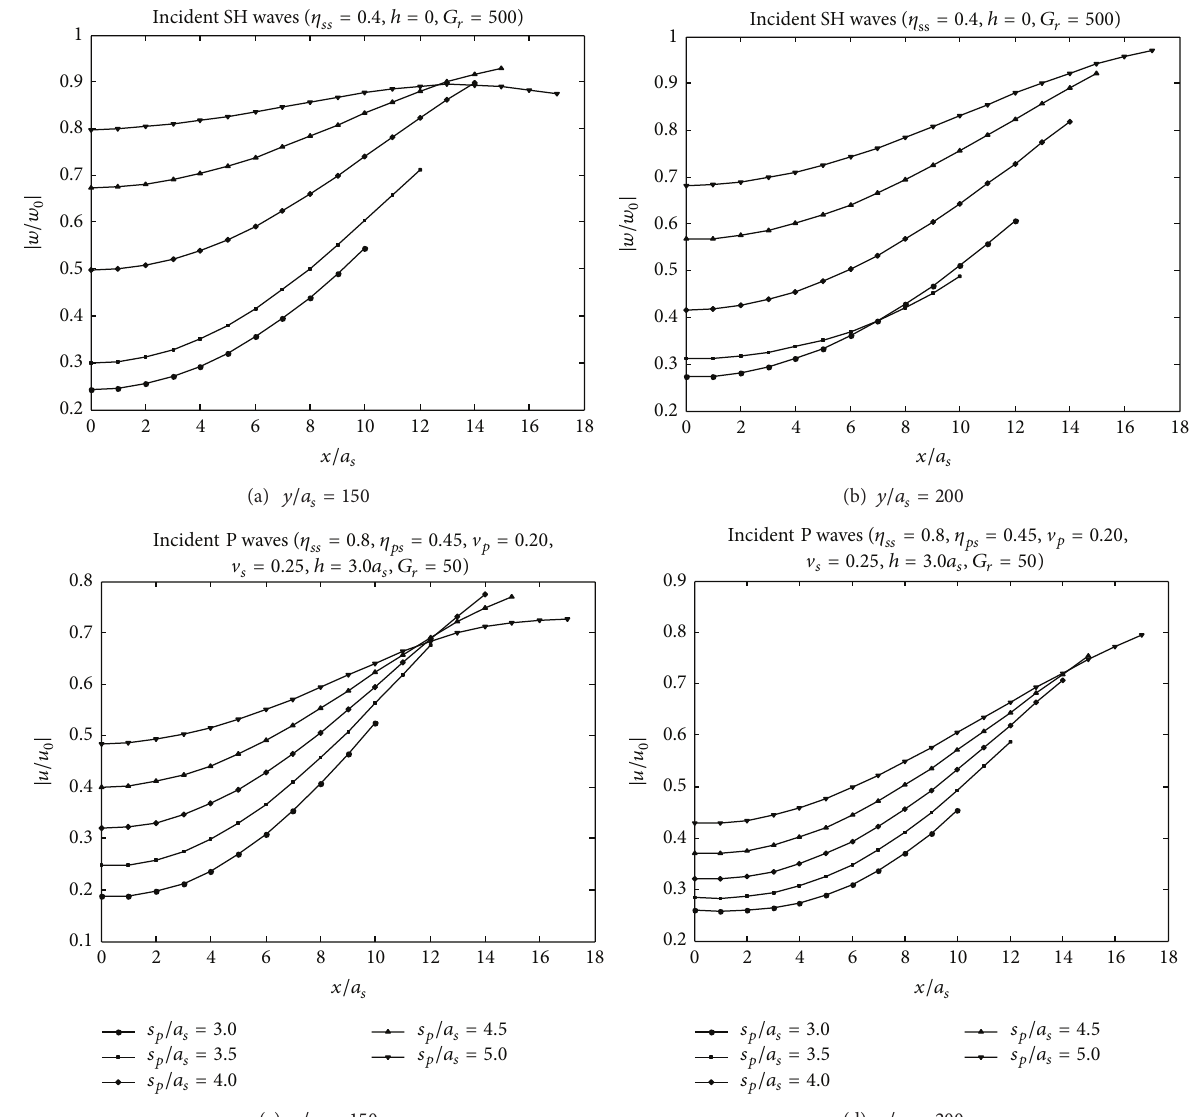
Figure 7: Normalized displacement amplitudes curves with different separations of tubular piles ( 𝑏 𝑠 = 0.9𝑎 𝑠 , 𝑚 = 4 , 𝑁 = 8